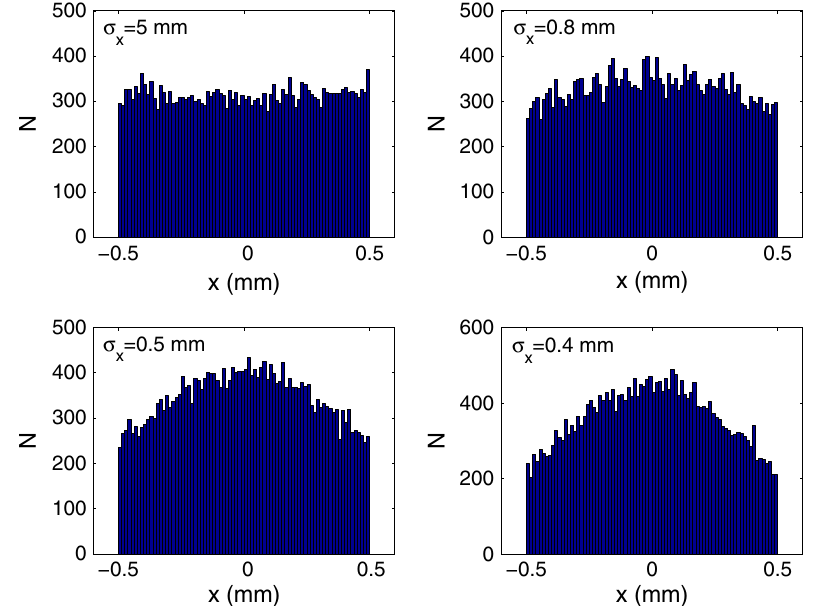
FIG. 1. Lineout intensity of the initial laser spatial distributions used in the simulations: the pure uniform laser spatial beam ( (cid:2) x ¼ 5 : 0 mm ), nearly uniform ( (cid:2) x ¼ 0 : 8 mm ), and different truncated-Gaussian laser spatial distributions ( (cid:2) x ¼ 0 : 4 – 0 : 5 mm ).